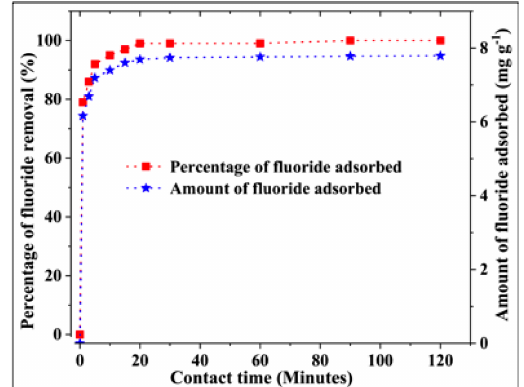
Figure 7. Amount of fluoride adsorbed for varying pH in the absence of calcium (initial fluoride concentration: 15 mg L − 1